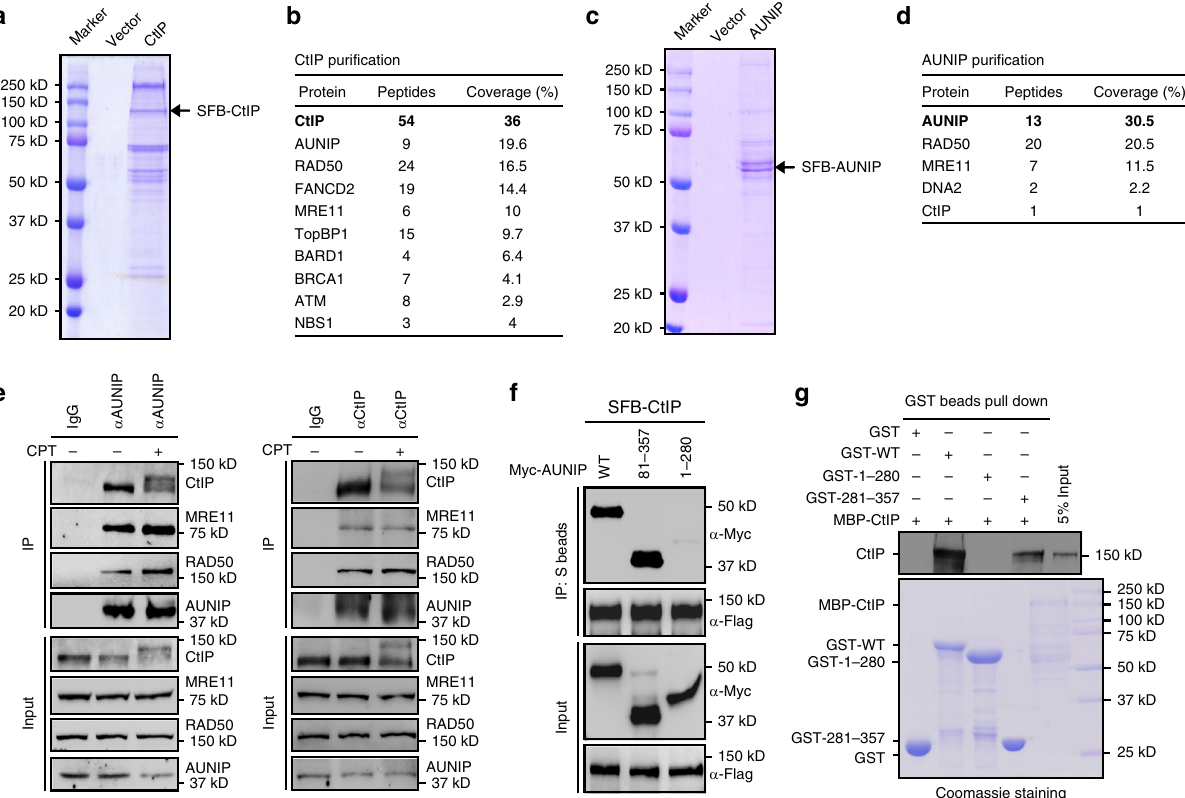
Fig. 1 Identi fi cation of AUNIP as a CtIP-associated protein. a , c CtIP ( a ) or AUNIP ( c ) protein complexes separated by SDS-PAGE were stained with Coomassie blue. b , d Proteins identi fi ed by mass spectrometric analyses of CtIP or AUNIP protein complexes are listed. Bait proteins are indicated in bold letters. e AUNIP interacts with CtIP and the MRN complex. HeLa cell lysates treated with Benzonase were precipitated with anti-AUNIP or anti-CtIP antibodies and were analyzed by immunoblotting with indicated antibodies. f AUNIP interacts with CtIP via its C-terminus. HEK293T cells transfected with indicated plasmids were lysed with NETN buffer 24 h post transfection. Cell lysates were then incubated with S-protein beads and immunoprecipitated proteins were analyzed by immunoblotting experiments using indicated antibodies. g Direct in vitro binding between recombinant GST-AUNIP and MBP- CtIP puri fi ed from E. coli . GST served as a negative control for CtIP binding. Top: CtIP was detected by immunoblotting experiment. Bottom: puri fi